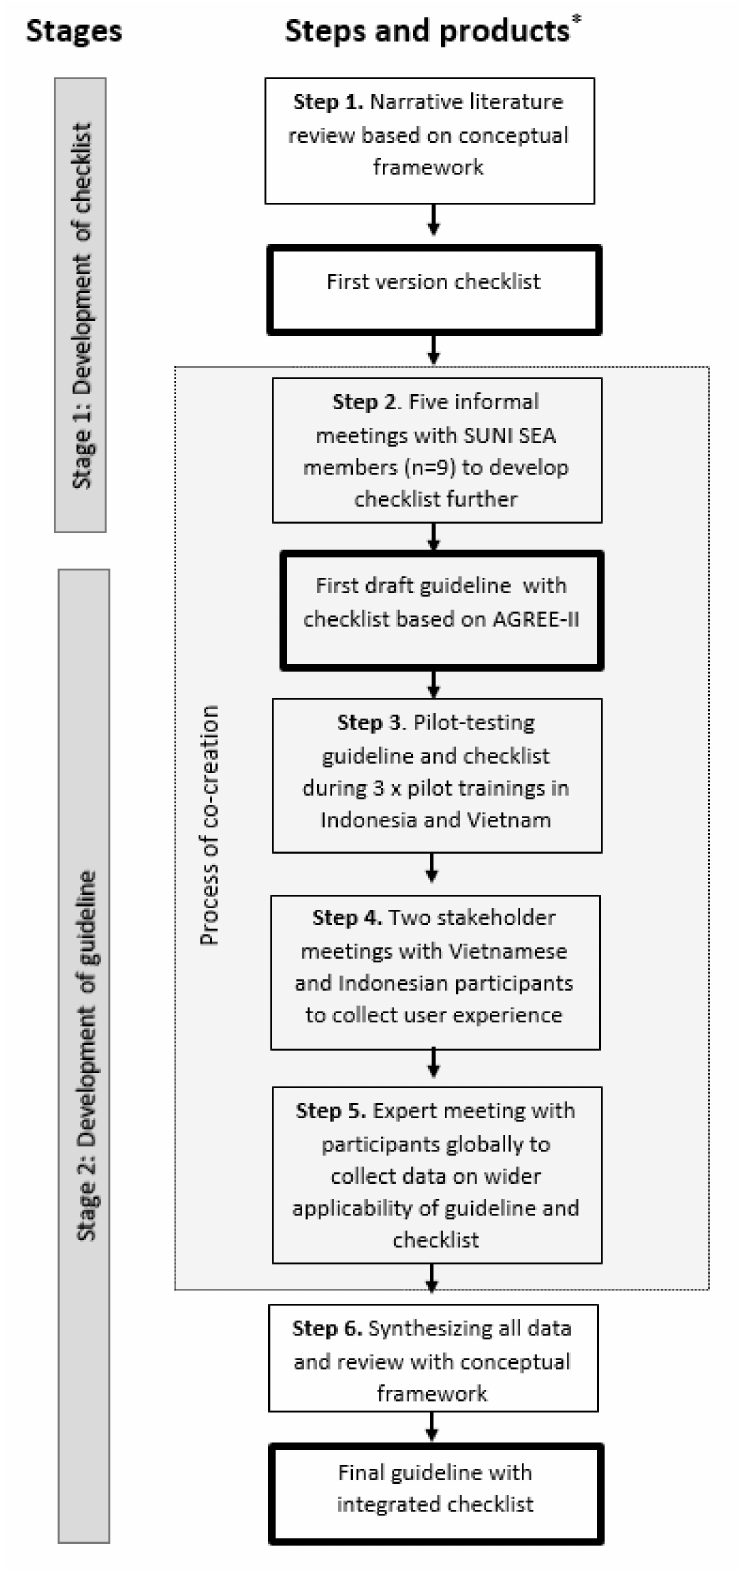
Figure 2. Design of the study structured in stages, steps, and products. * Boxes with bold outline denote products created in the